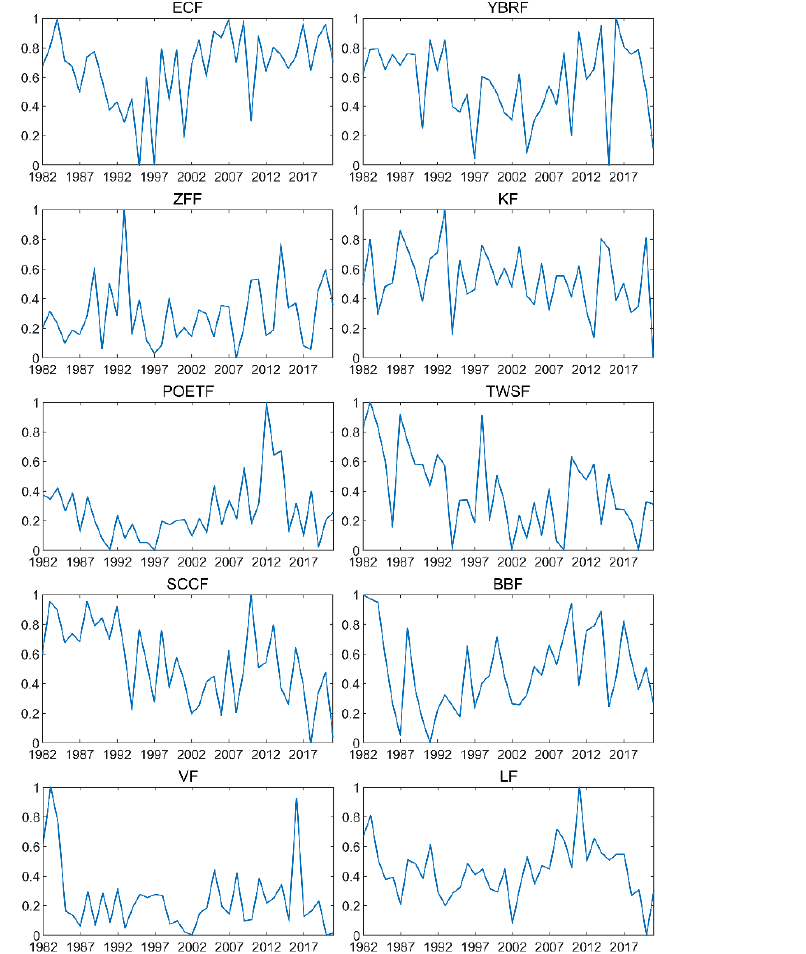
Figure 7. Line chart of long-term changes in 18 frontal regions (the blue line indicates the interannual variation trend of the frontal normalized FP